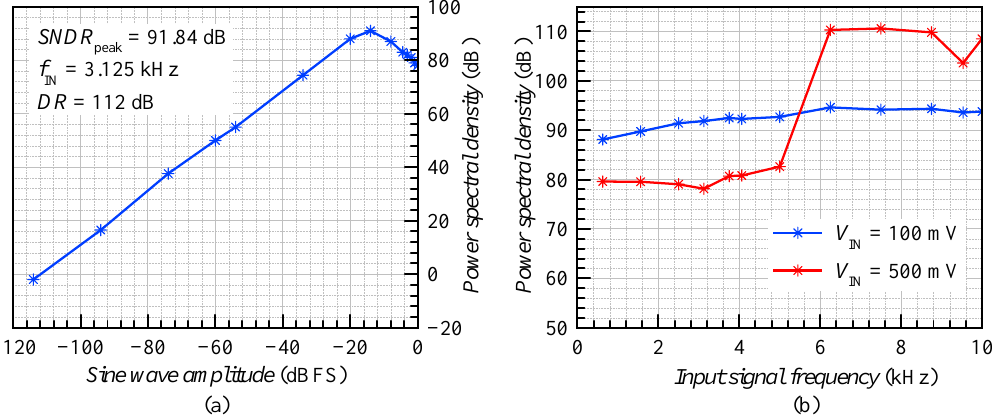
Figure 12. Plot of the SNDR vs. the ( a ) input sine wave amplitude and ( b ) input signal